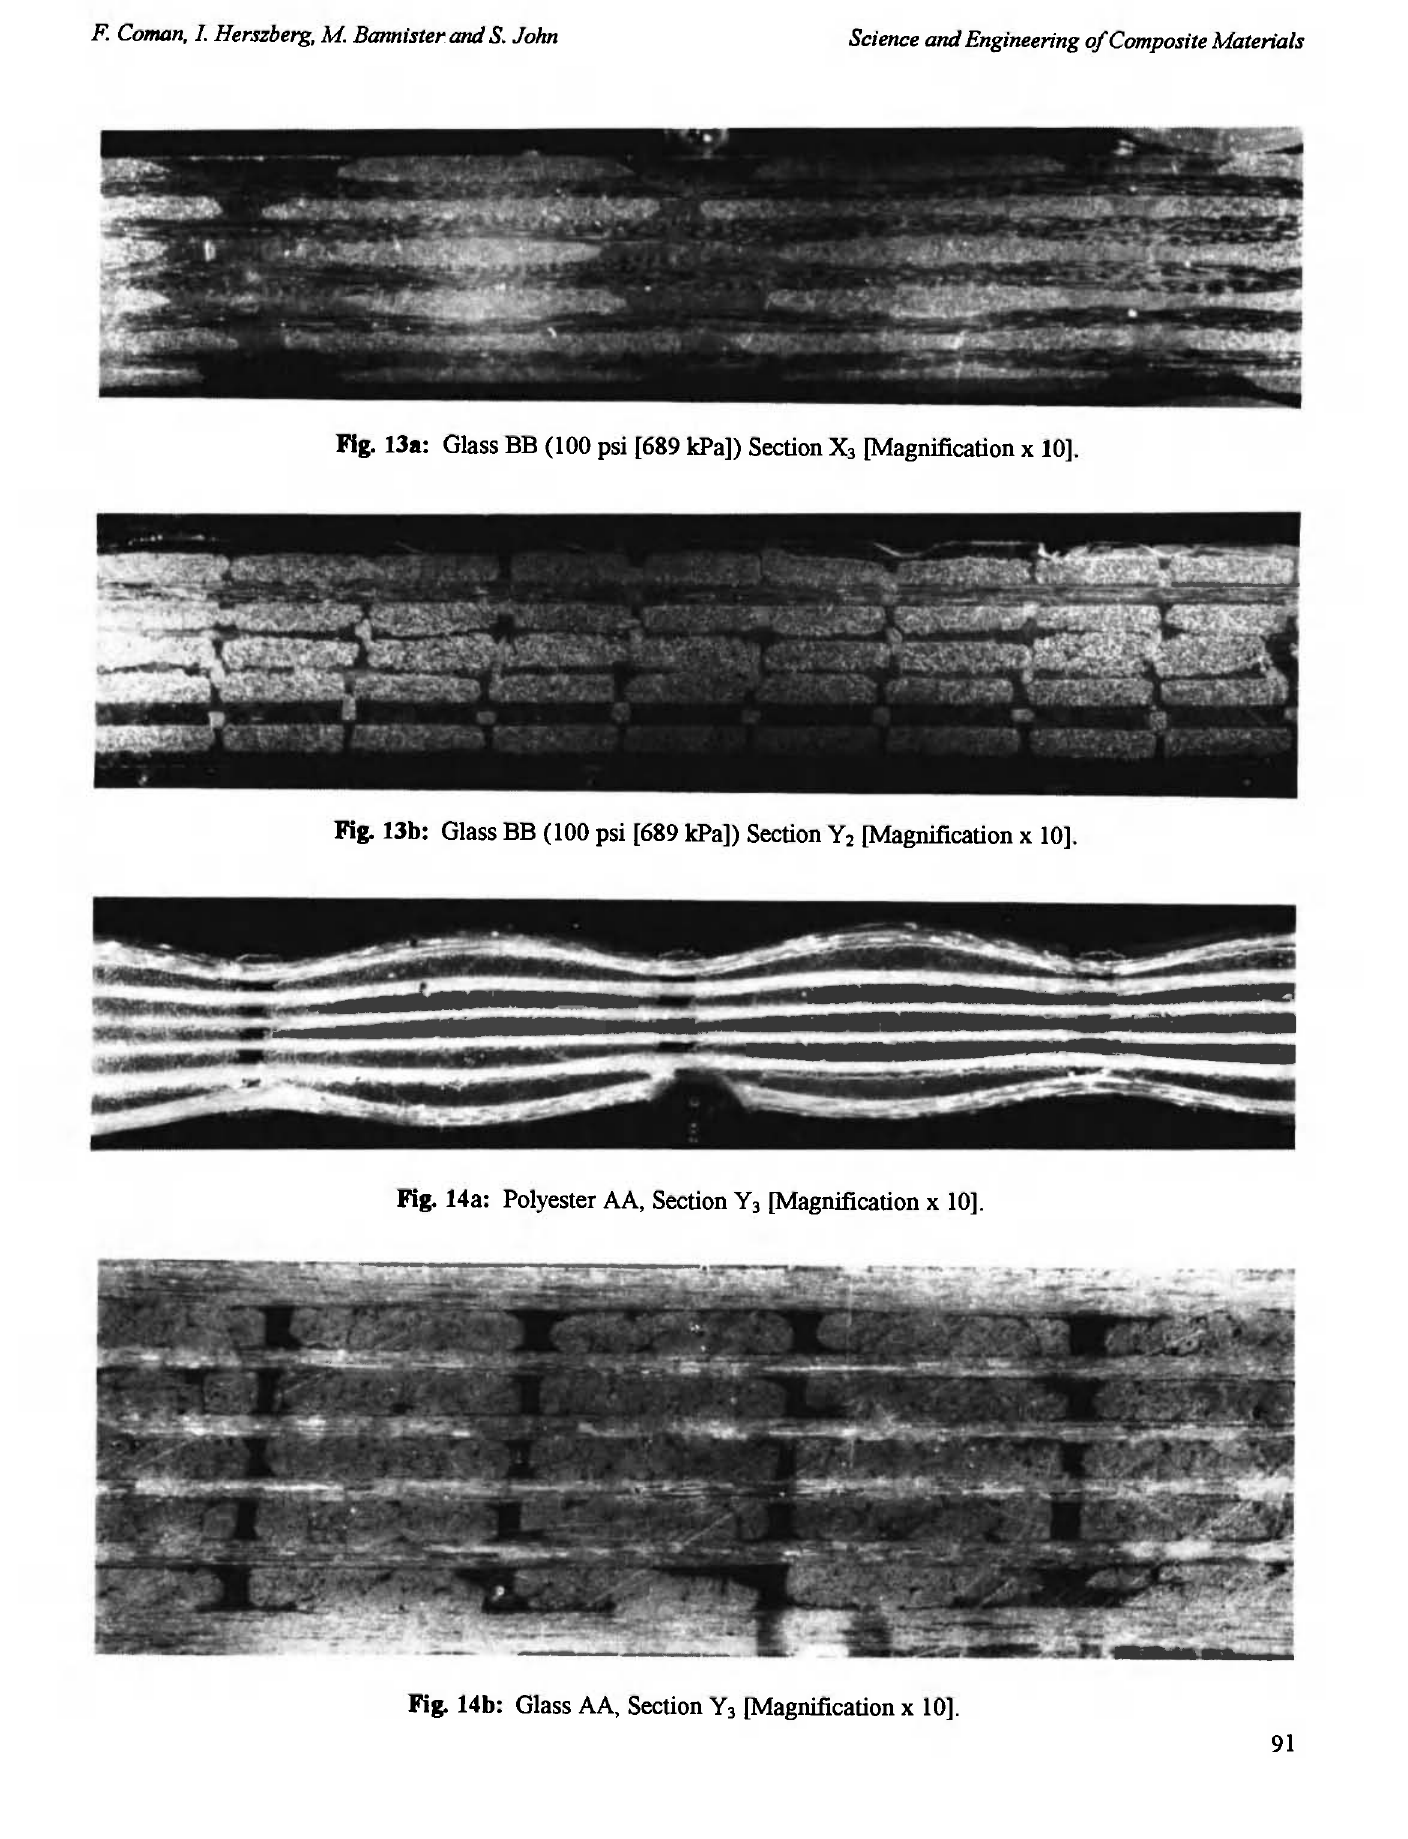
[Magnification χ 10], 3